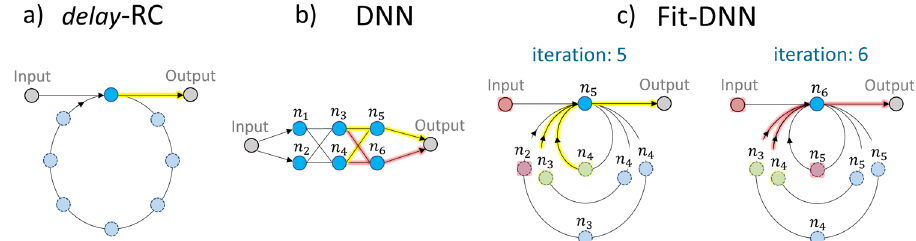
Fig. 2 Deep neural networks via time delay and sequential sampling. Illustration of a delay-based RC scheme with a delay loop and one physical node (blue circle), b deep neural network (DNN) with three layers (each layer contains two physical nodes), and c corresponding folded-in-time deep neural network (Fit-DNN) realized via three feedback loops with time-varying feedback strengths and sequential sampling of the physical node (iteration 5 and 6 are